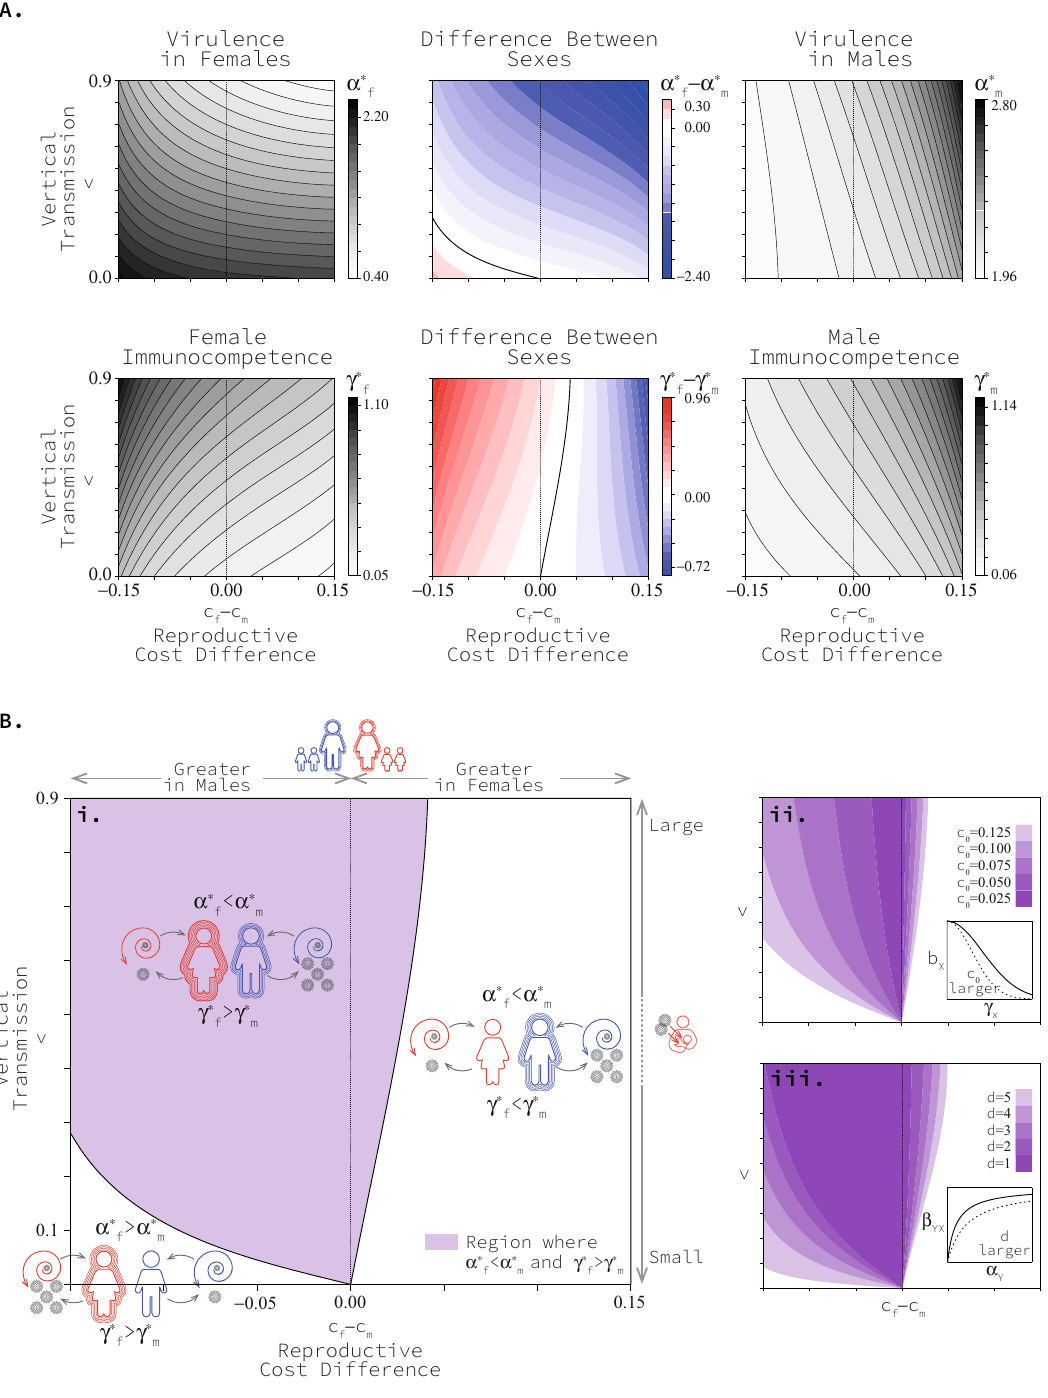
Fig. 4 | Co-evolved levels of virulence and immunocompetence in each sex as verticaltransmissionanddifferenceinthecostofimmunefunctionchanges. In panel A blackandwhitesub-panelspresentthe virulenceandimmunocompetence levels in each of the sexes, while coloured centre sub-panels present the virulence andimmunocompetenceofthesexesrelativetoeachother.Inthesesub-panelsred areascorrespondtogreatervaluesinfemalesandblueareascorrespondtogreater values in males. Black curves in centre sub-panels correspond to zero differences